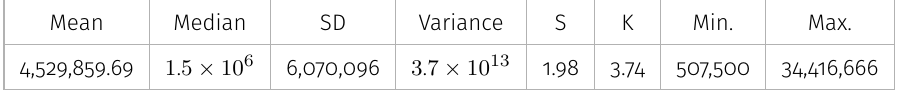
Table VIII. Descriptive statistics for baseball players data.